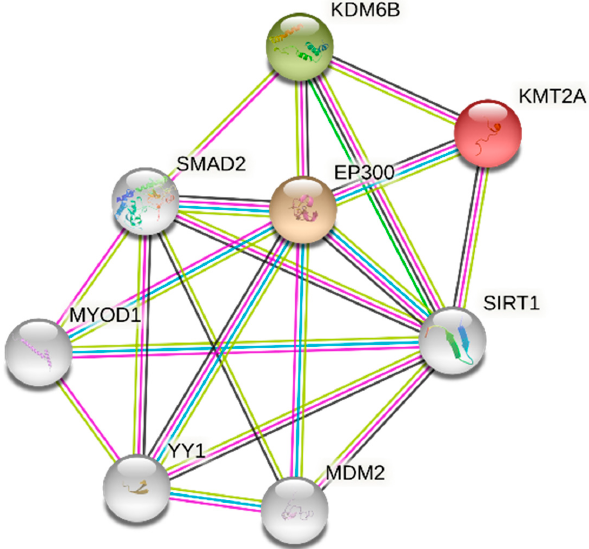
Figure 5. Protein–protein association network of newly identified KDM3A substrates. STRING-generated network showing the identified KDM3A substrates (colored nodes) and associated proteins (white nodes) [56]. Multiple types of interactions are shown: in magenta, experimentally determined known interactions; cyan, known interactions from curated databases; bright green, gene neighborhood; lime green, textmining; black, co-expression. A tabular form of this network is depicted in Supplementary Table S5.